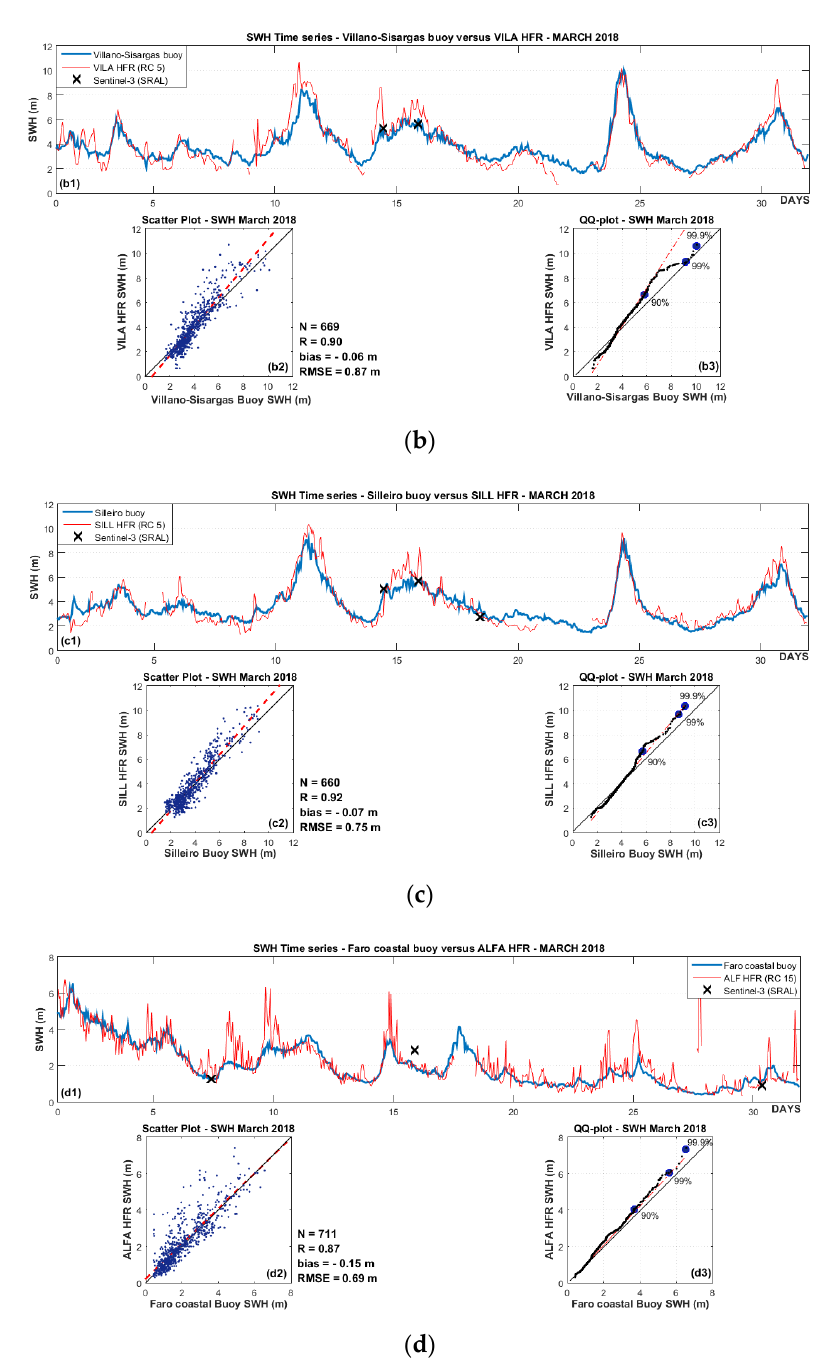
Figure 8. One-month comparison of HFR SWH against in situ observations—March 2018 (Emma Storm). ( a ) PRIO HFR vs. Baves buoy; ( b ) VILA HFR vs. Villano-Sisargas buoy; ( c ) SILL HFR vs. Silleiro buoy and ( d ) ALFA HFR vs. Faro coastal buoy. ( a1 , b1 , c1 , d1 ) Time series plots (blue line: buoy observations, red line: HFR derived SWH; black crosses: SRAL measurements); ( a2 , b2 , c2 , d2 ) Scatter plots (blue dots: observation pairs, red dashed line: best linear fit); ( a3 , b3 , c3 , d3 ) QQ-plots (black dots: buoy against HFR quantiles; black line: quantiles normal distribution; red dashed line: quantiles distribution and blue filled dots: 90, 99 and 99.9 quantiles). Statistics metrics of the comparison between the buoy and HFR SWH for March 2018 are gathered on the right bottom side of the scatter plots.